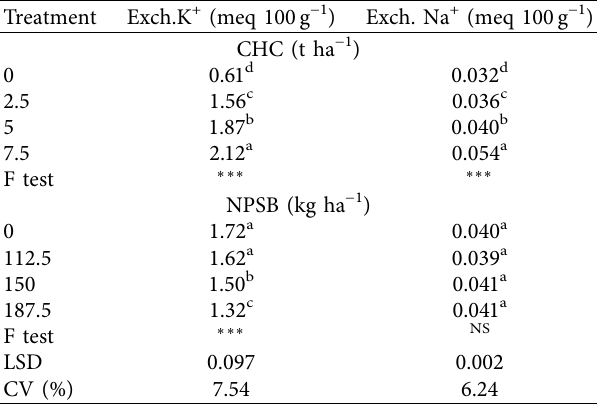
Table 4: The main effect of CHC and NPSB fertilizers on ex- changeable K + and Na + of soils of potato field.